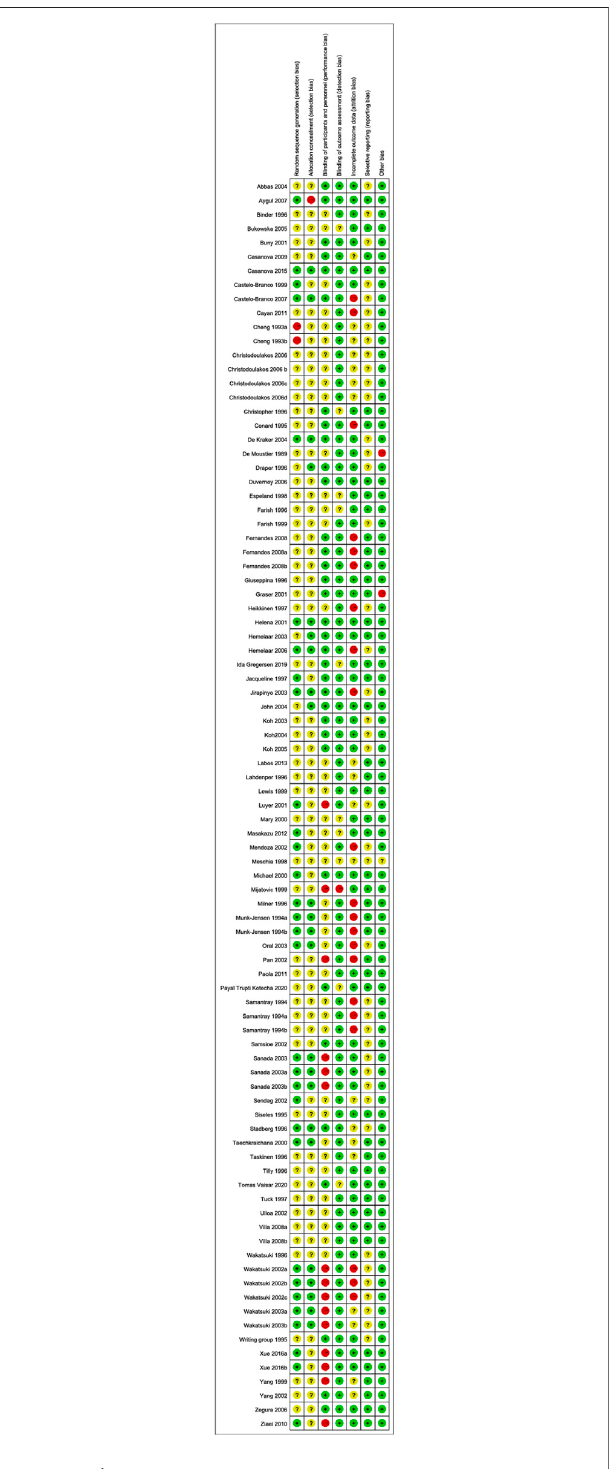
FIGURE 2 | Summary of risk in